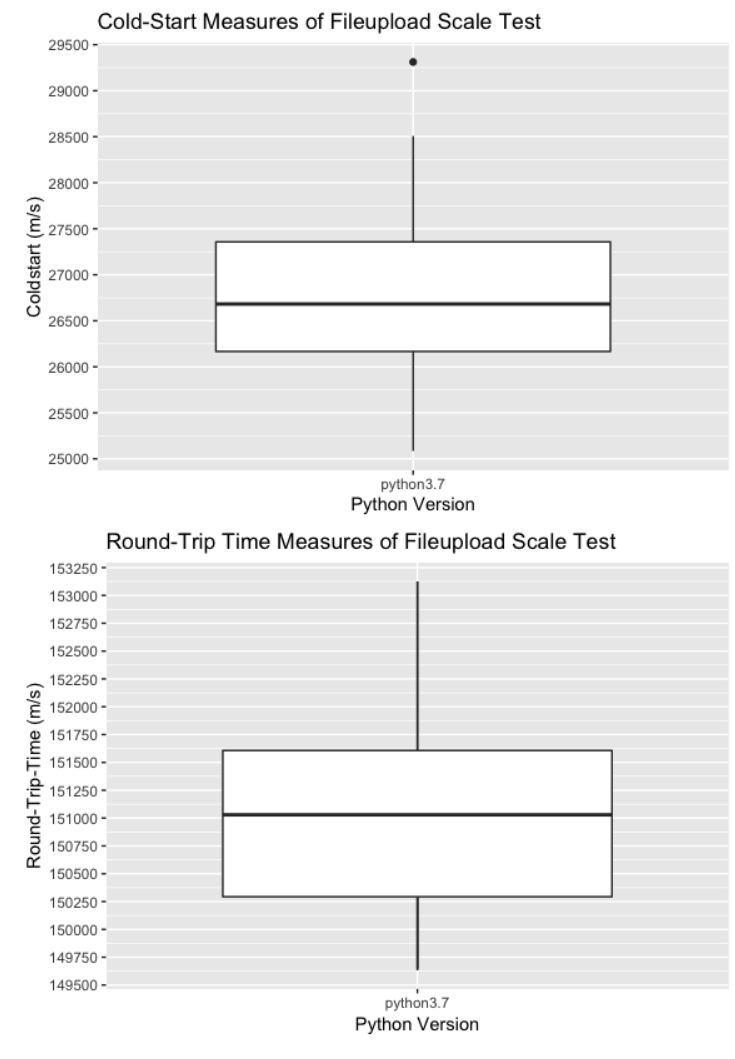
Figure 4. Boxplot of Scale Test Cold-Start and Round-Trip-Time results for Scale